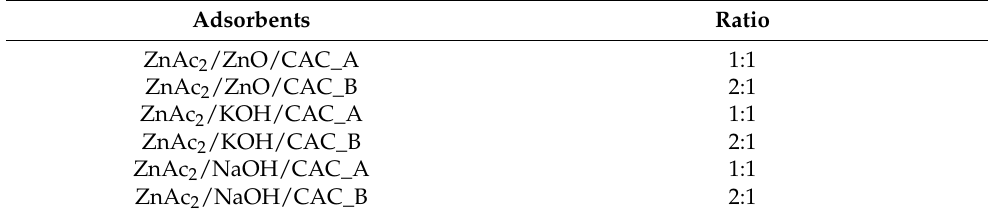
Table 5. Description of prepared